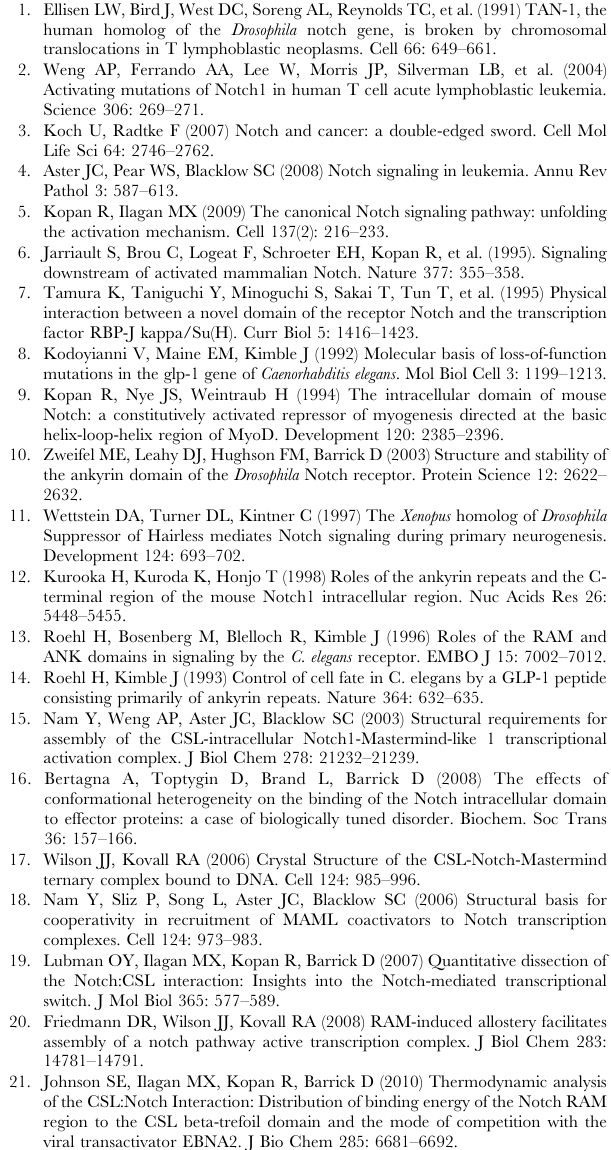
Table S1 Fold activation and standard error for CSL-dependent transcription reporter assay. Each reaction includes 225 ng TP1- DNA in addition to those components listed in the